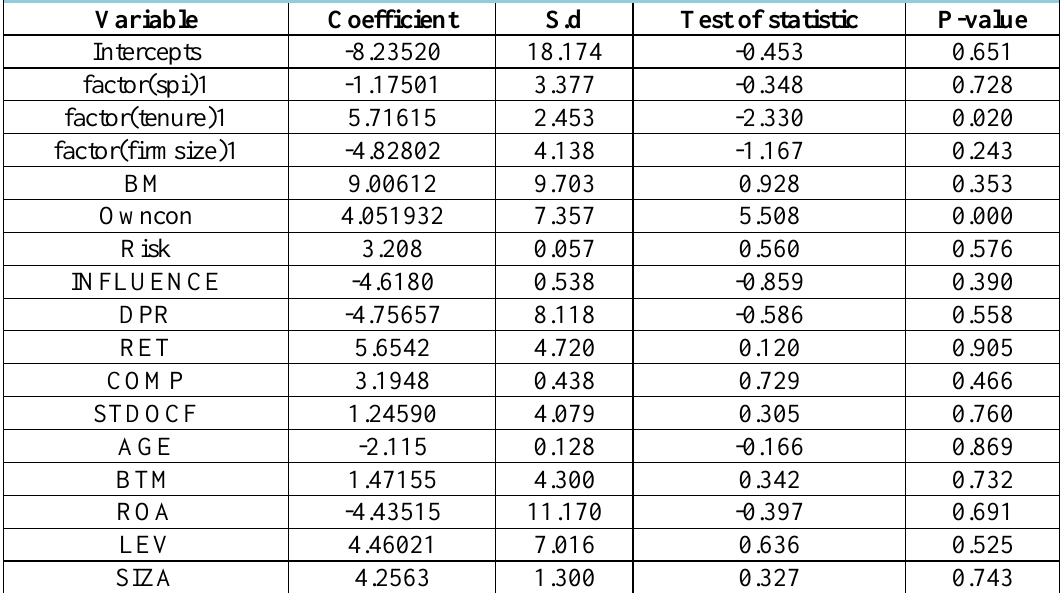
Table 3. The results of the model fitting through random effects of extended panel regression